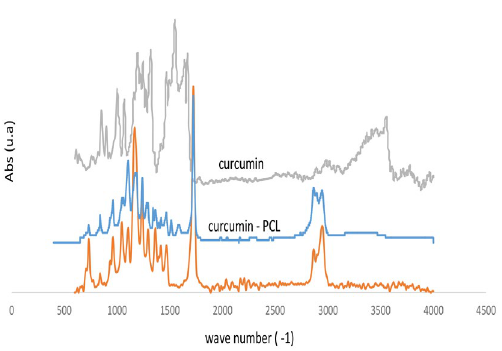
Fig. 3. ATR-FTIR spectra of Cur, PCL,